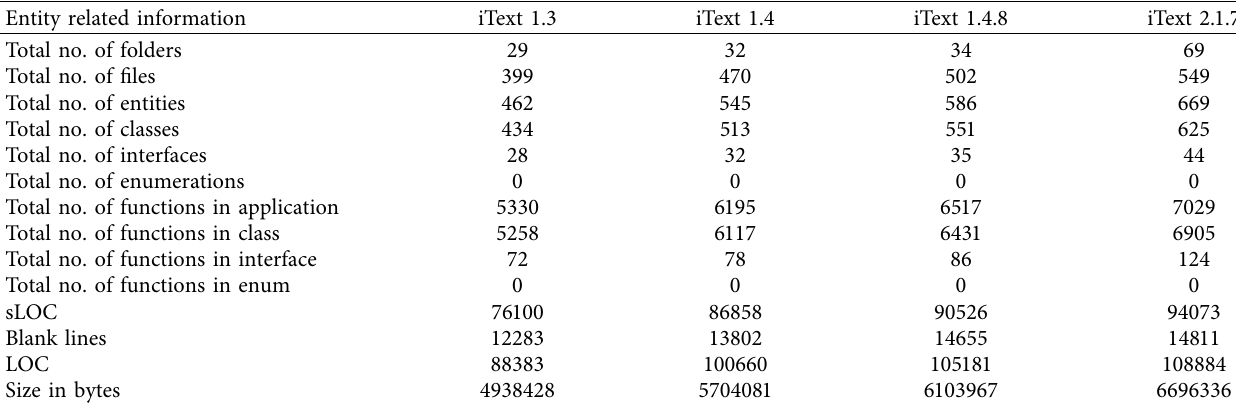
Figure 2: Process of Relationship Table 1: Facts about entities in iText dataset.